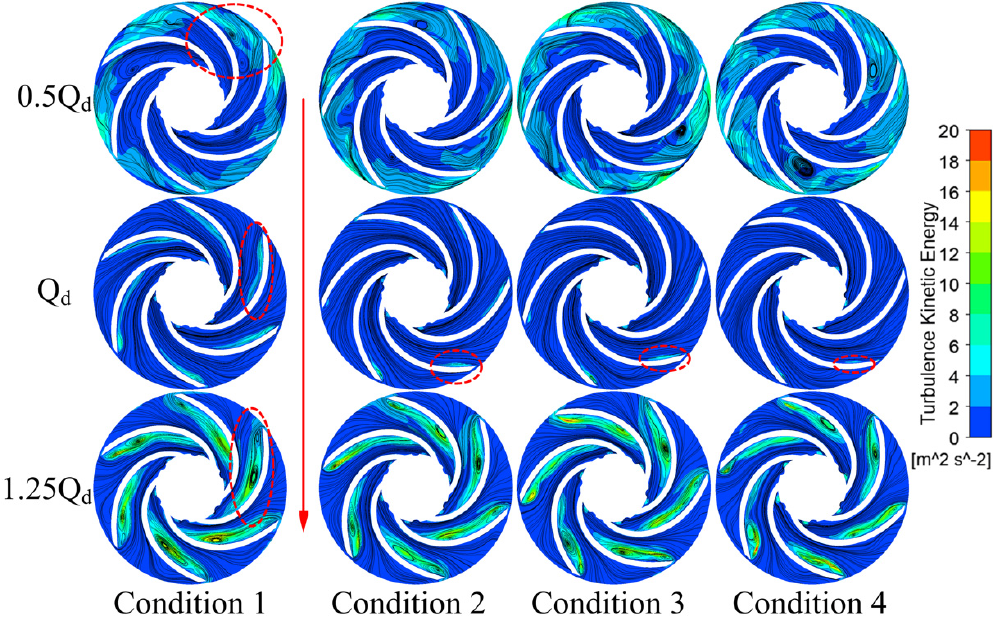
Figure 13. Turbulent kinetic energy distribution diagram for the impeller channel’s radial section.